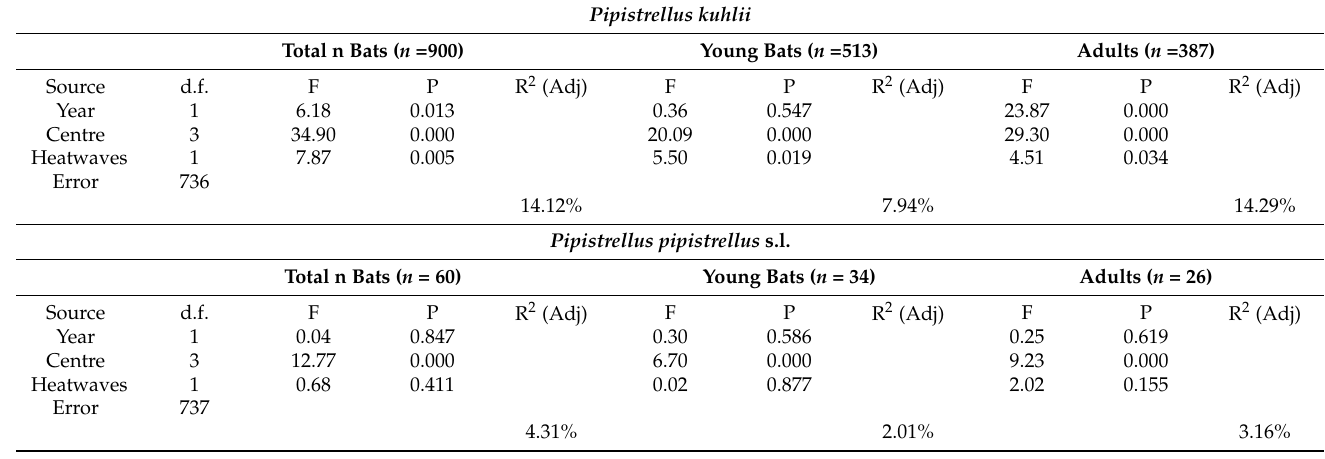
Table 2. Results of a GLM ANCOVA on Pipistrellus kuhlii and P. pipistrellus admitted at four Italian rehabilitation centres, years 2008–2021. Temperature = weekly mean of maximum temperatures